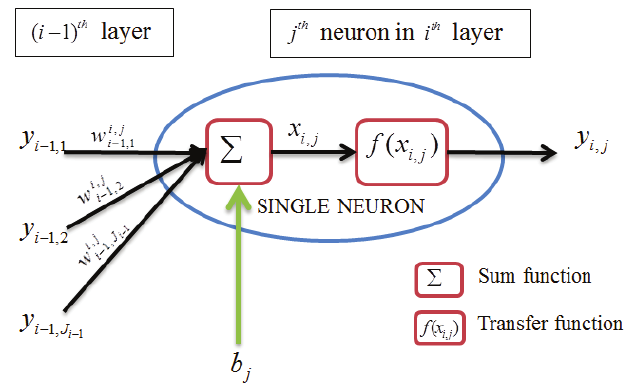
Fig. 2 – Operation of single neuron in Figure 2 Operation of single neuron in ANN